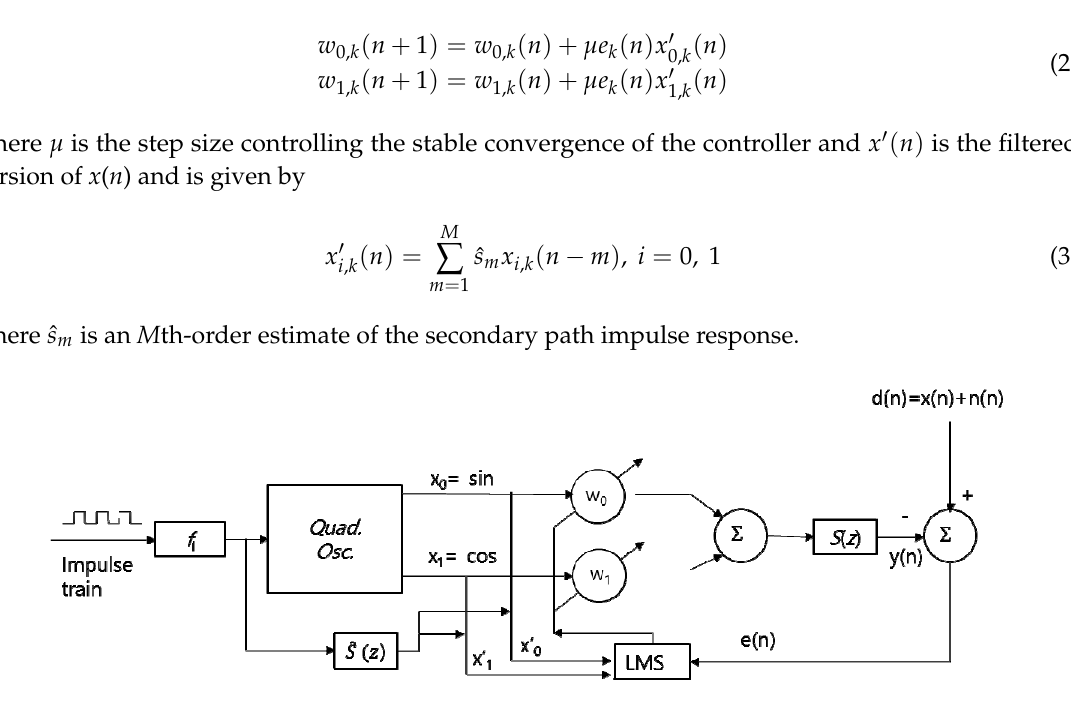
Figure 1. Narrowband FxLMS algorithm based adaptive notch filter.